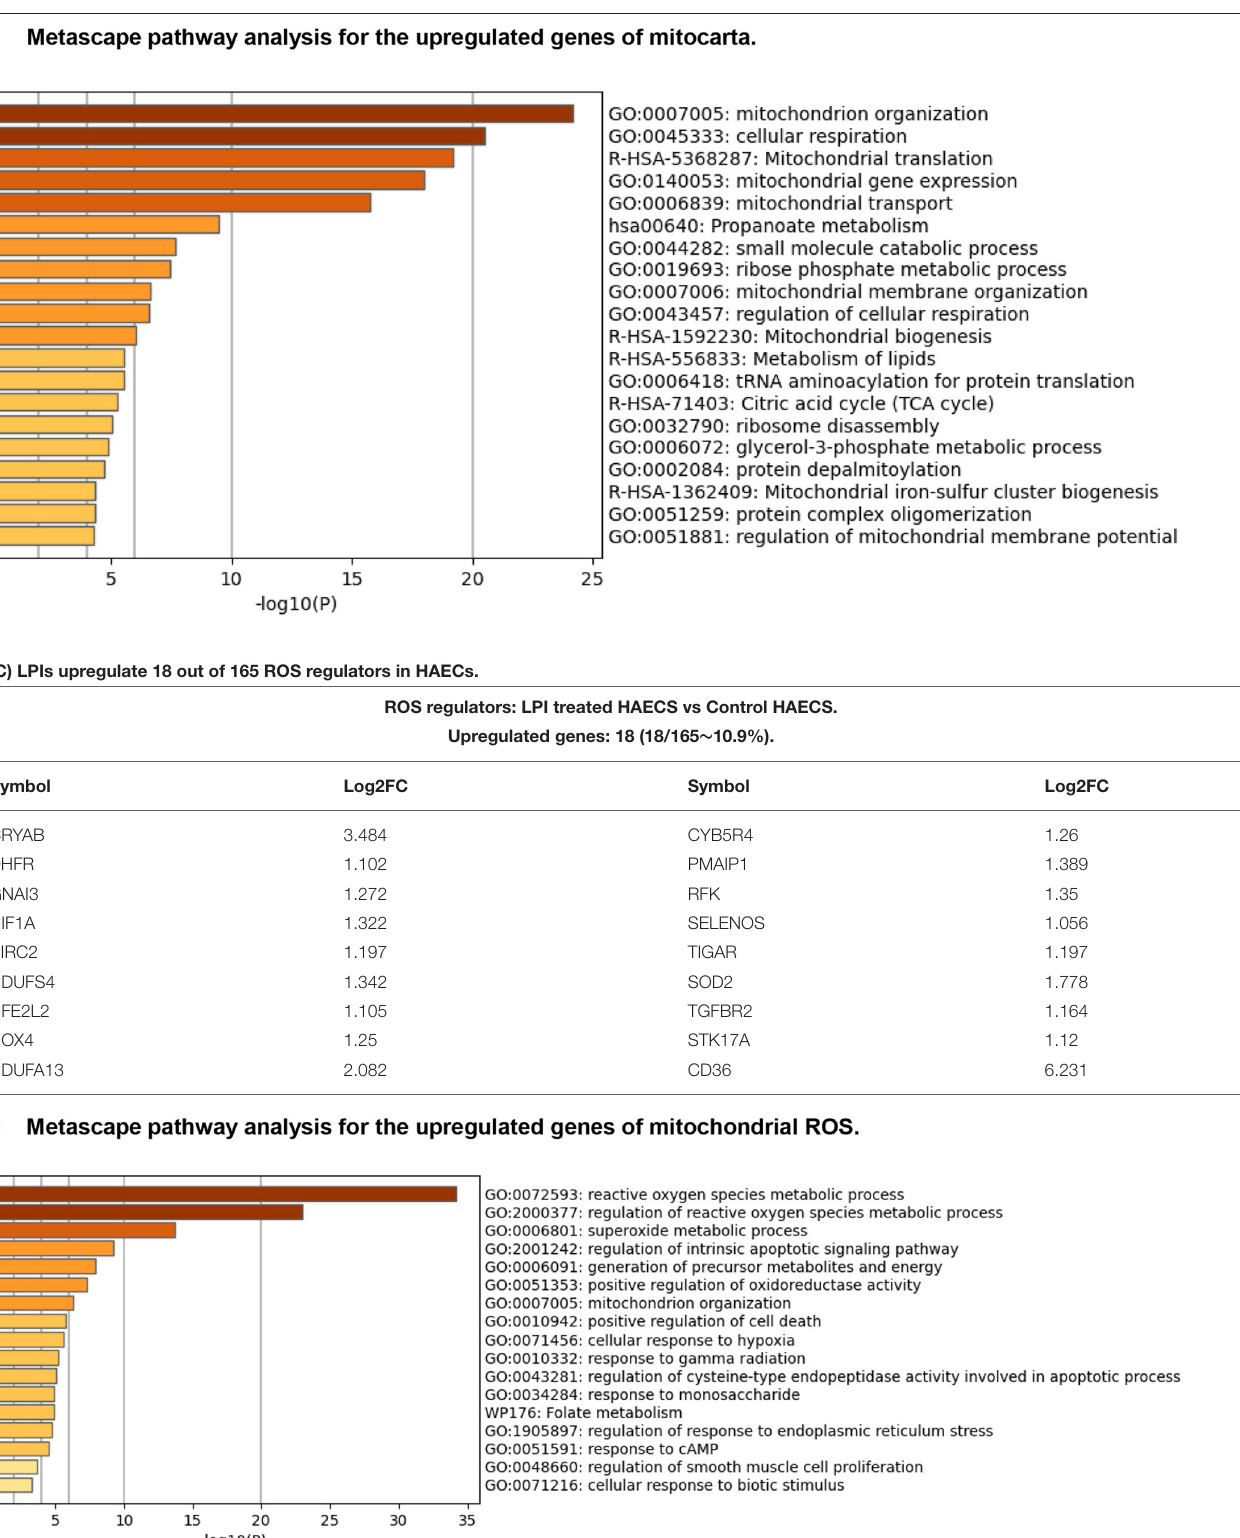
FIGURE 9 | Mitochondrion-related genes showed significant upregulation in LPI-treated HAECs compared with the control HAECs. (A) One hundred fifty-two out of 1,158 mitocarta genes were significantly upregulated in LPI-treated HAECs. (B) Metascape pathway analysis for the upregulated genes of mitocarta. (C) Eighteen mitochondrial reactive oxygen species (ROS) regulators were significantly upregulated in LPI-treated HAECs. (D) Metascape pathway analysis for the upregulated genes of mitochondrial ROS.